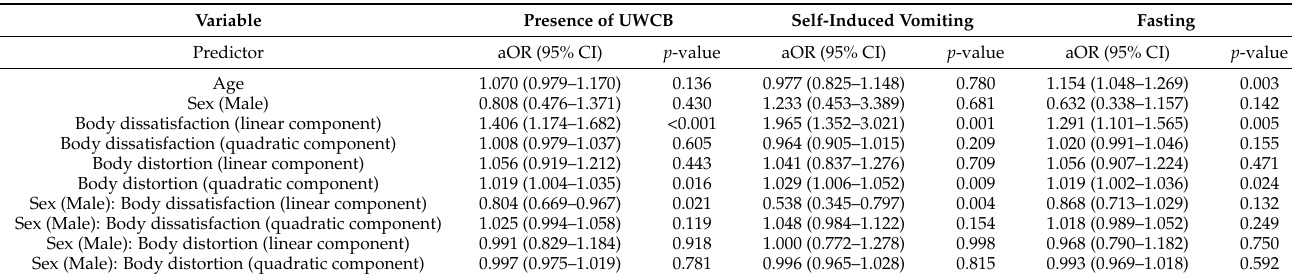
Table 3. Association between age, sex, body dissatisfaction and body distortion with unhealthy weight control behaviors ( n =